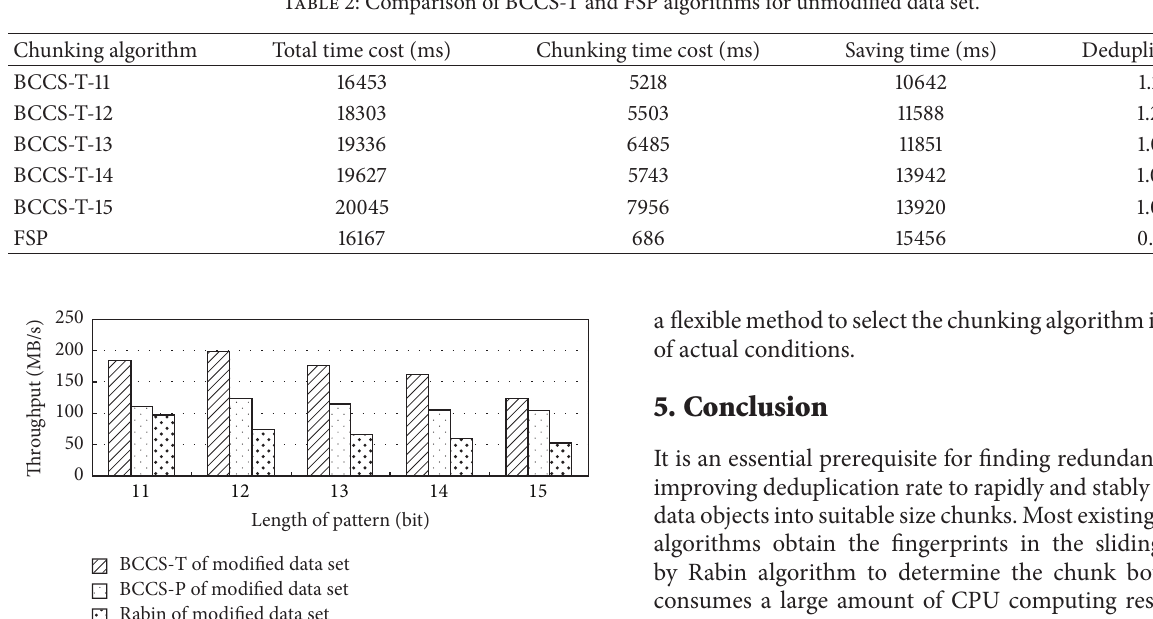
Table 2: Comparison of BCCS-T and FSP algorithms for unmodified data set.